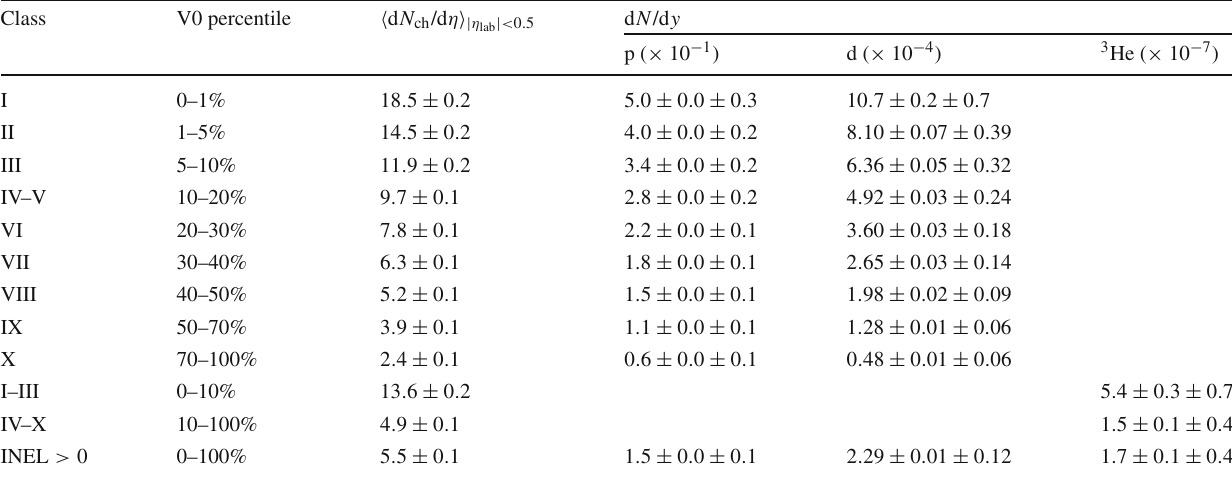
Table 1 Multiplicity classes for the different measurements, with the corresponding charged-particle multiplicity density at midrapidity (cid:5) d N η (cid:6) and percentiles of the INEL > 0 pp cross section, and p ch /d